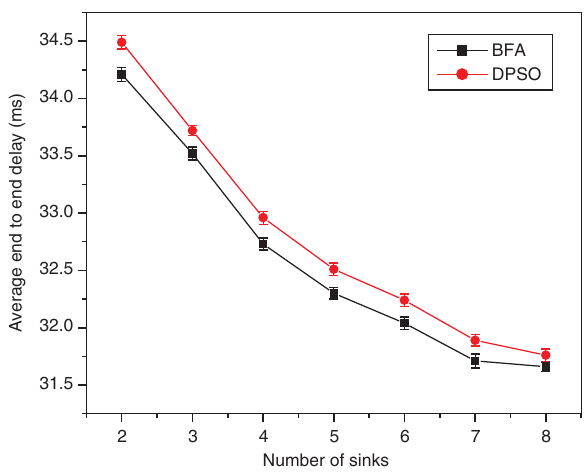
Figure 5: Number of Sinks vs. Average End to End